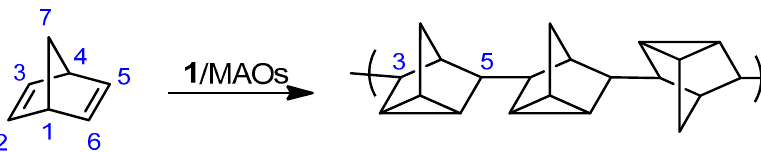
Figure 8. X ‐ ray powder diffraction profile of entry 6.